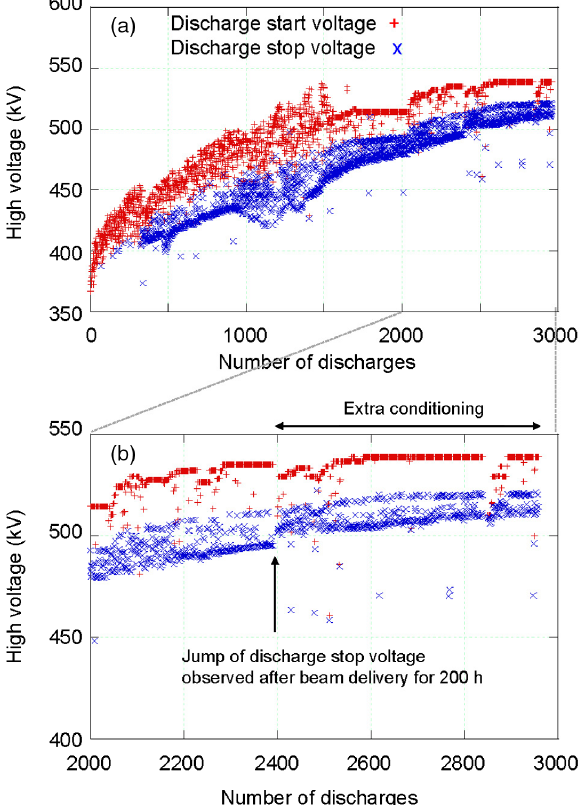
voltages as a function of the number of discharges. (b) Enlarge- ment from discharges 2000 to 3000. Discharge stop voltage jumped to 501 kV at the beginning of extra conditioning after beam delivery for 200 h.